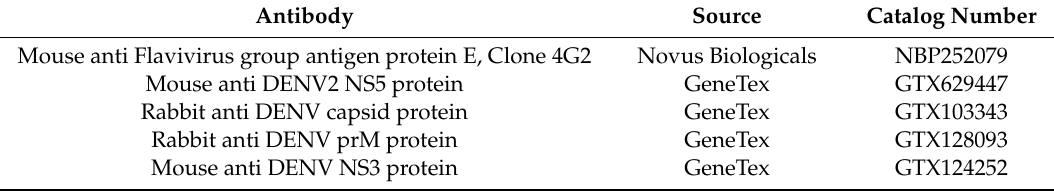
Table 4. Virus Protein